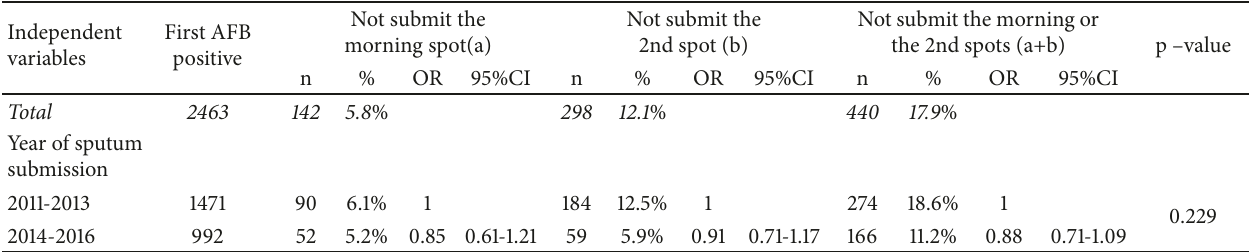
Table 3: Mono-variate analysis the association between dropout and registration of sputum submission period at public health facilities in Addis Ababa, Ethiopia, from